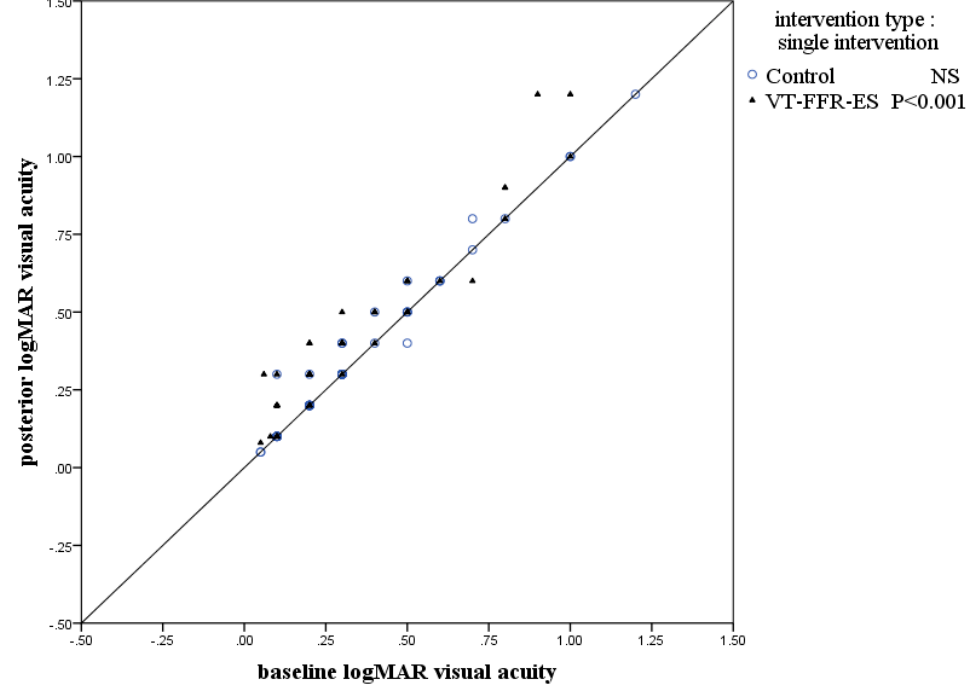
Figure 3. The identity plot presents the distribution of pre- and post-individual logMAR visual acuity between the single Control and VT-FFR-ES intervention types. The upper half of the identity line means a worse visual acuity than the baseline; the lower half of the identity line means a better visual acuity than the baseline. VT-FFR-ES: vision training, frequency following response and electrical stimulation; Control: no function group of VT-FFR-ES. Paired t -test NS, non-significant and p < 0.001. In the chronic intervention, the average spherical equivalents in the VT-FFR-ES and Control groups were − 2.59 ± 1.88 D and − 2.56 ± 1.79 D, respectively, in the pre-test, and − 2.38 ± 1.72 D and − 2.66 ± 1.91 D, respectively ( p < 0.001, Table 3), in the post-test. Figure 4 presents an identity plot for pre- and post-test spherical equivalent values after 4 weeks of chronic